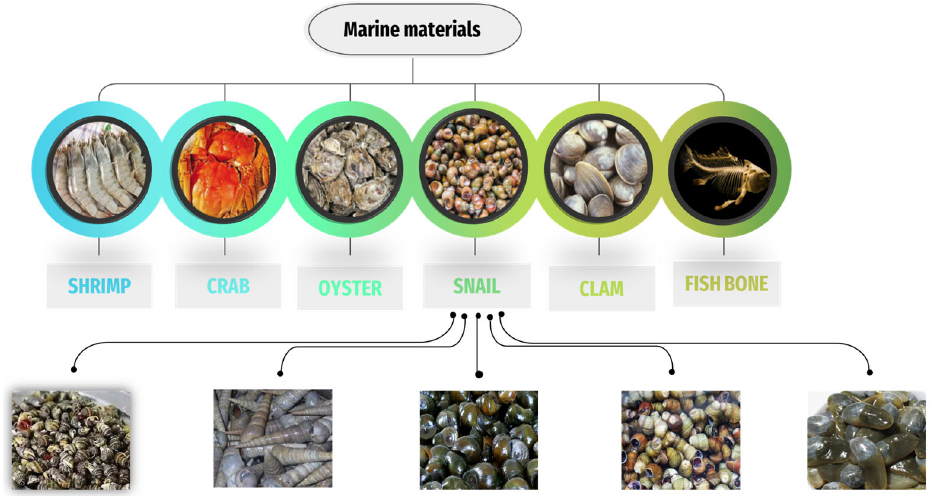
Figure 1. Popular marine materials in recent years in the application of adsorbents for wastewa- ter